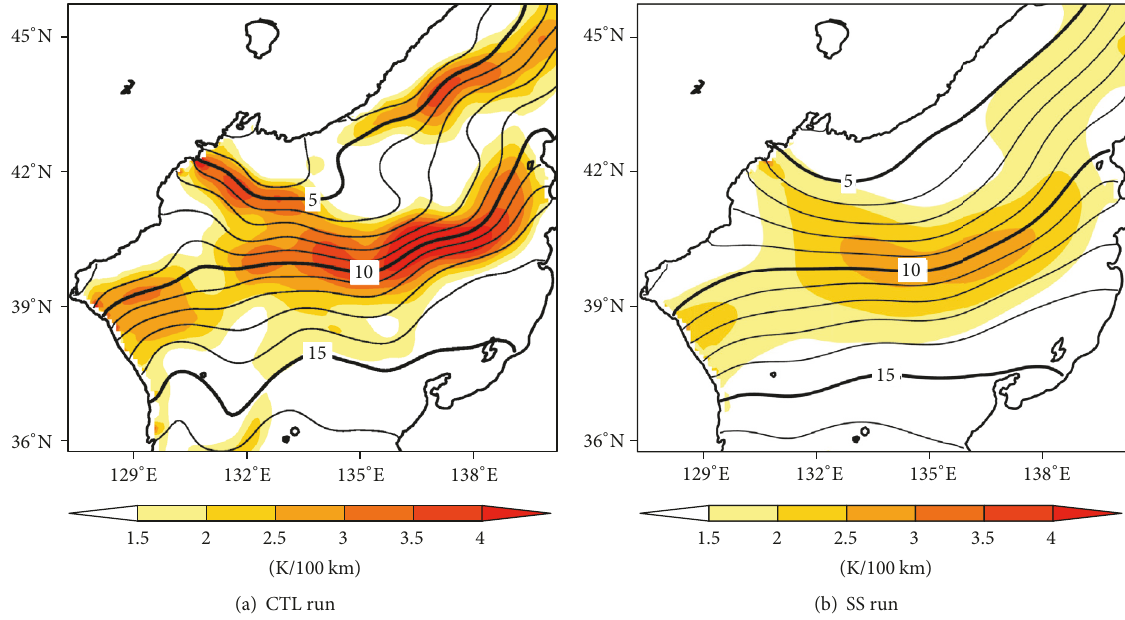
Figure 12: (a) Spatial distribution of OISST averaged over the period of 2000–2014. The contoured interval is 1K. The shading denotes the horizontal SST gradient (K/100km). (b) As in Figure 12(a) but for horizontally smoothed OISST.